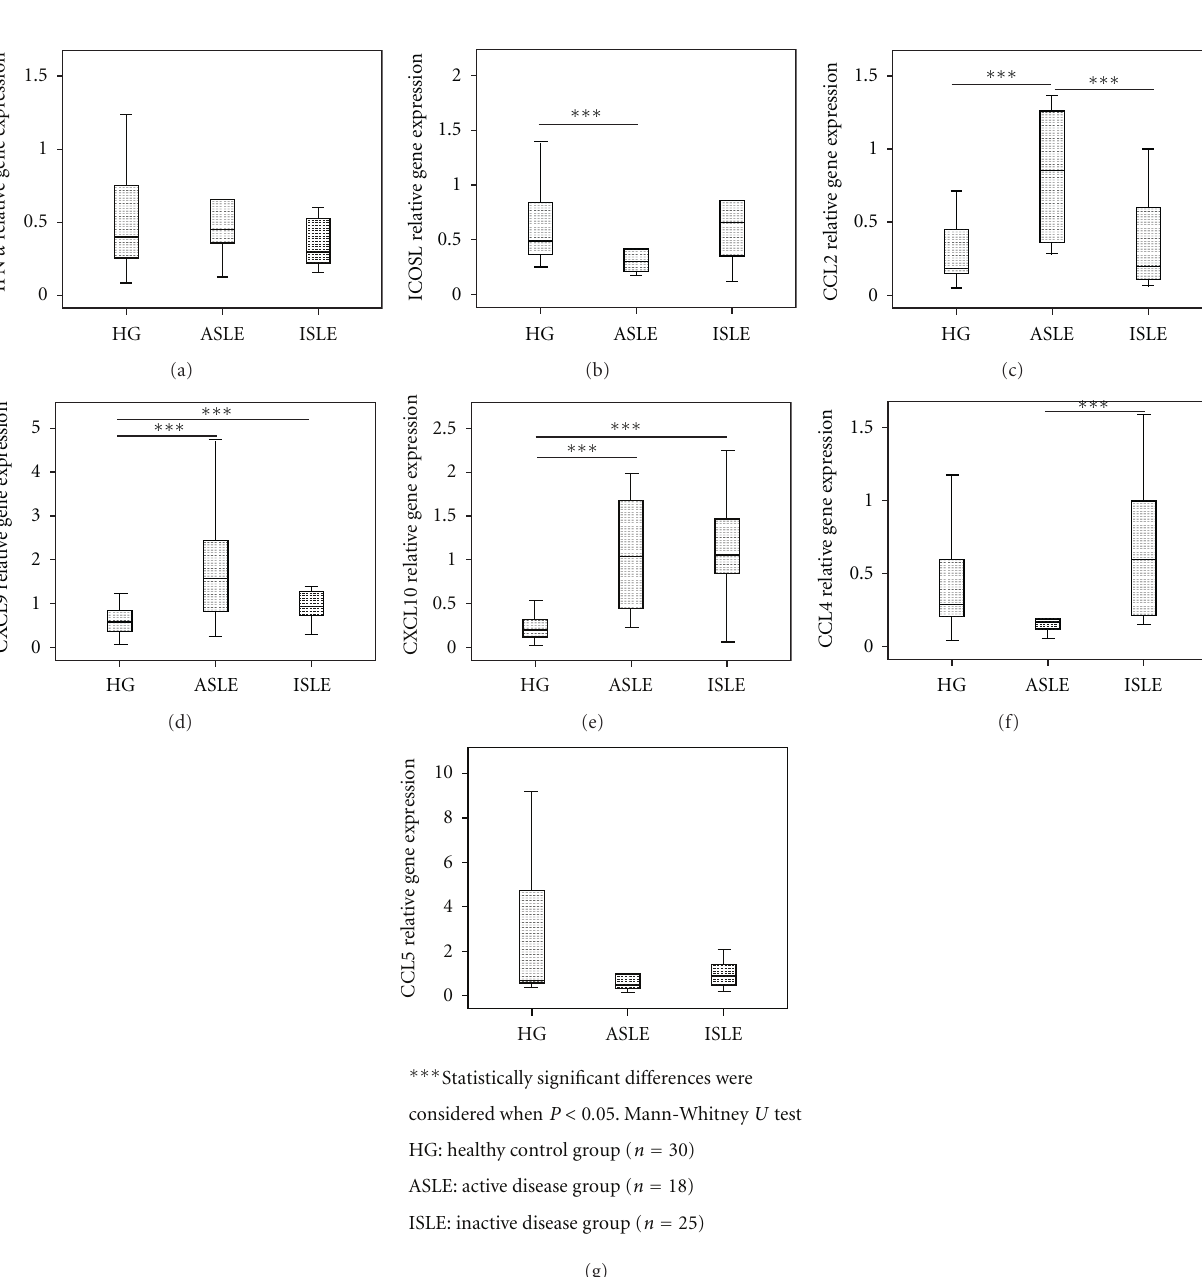
Figure 2: IFN- α , ICOSL, CCL2, CXCL9, CXCL10, CCL4, and CCL5 relative gene expression in cell-sorted monocytes in the three studied groups (HG, ASLE, and